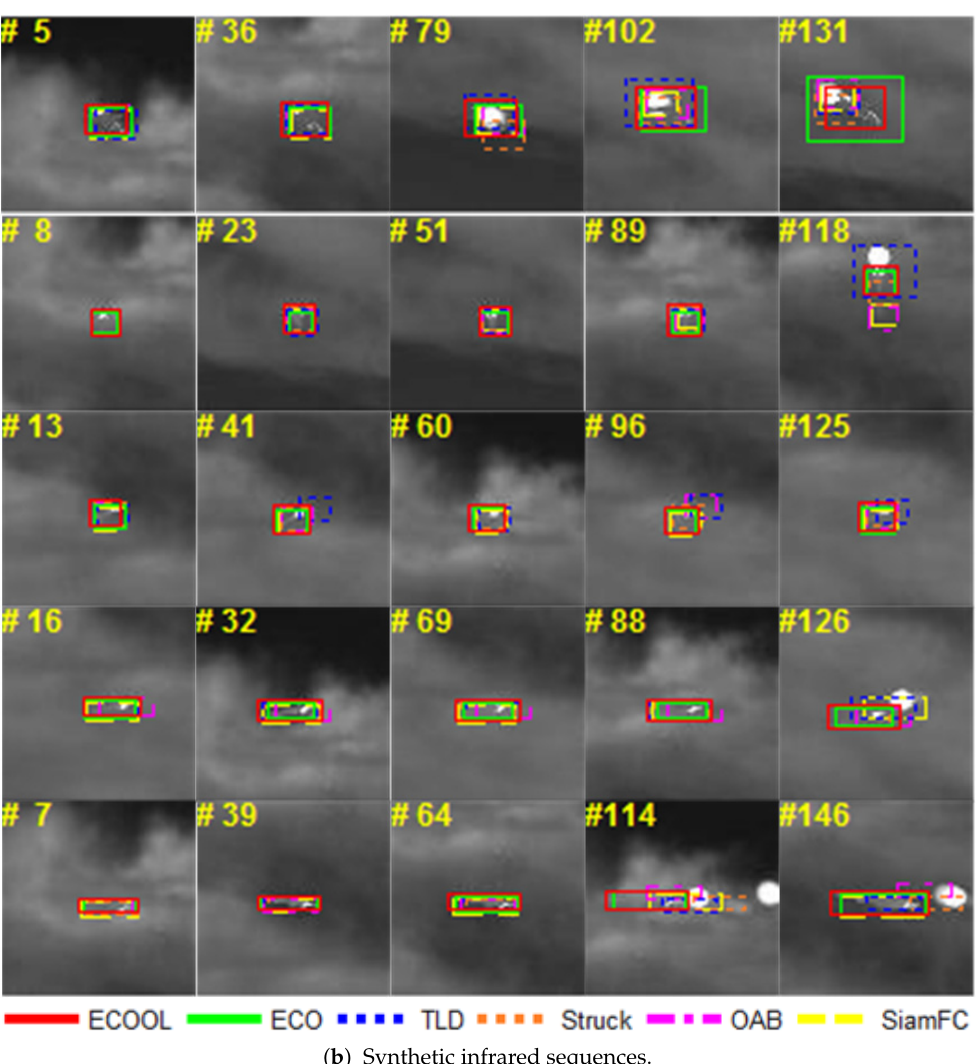
Figure 16. Sample tracking results of ECOOL, ECO, TLD, Struck, OAB, and